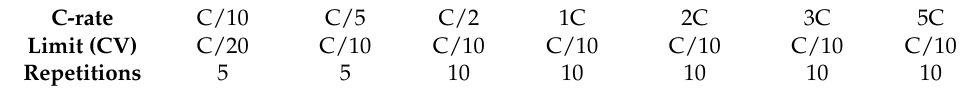
Table 2. Parameters of constant current-constant voltage (CCCV)